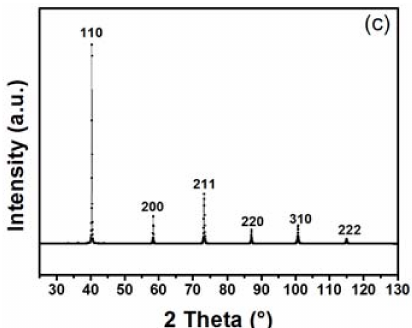
Figure 1. The initial tungsten powder: ( a ) SEM image; ( b ) the particle size distribution; ( c ) the X-ray diffraction (XRD) pattern.